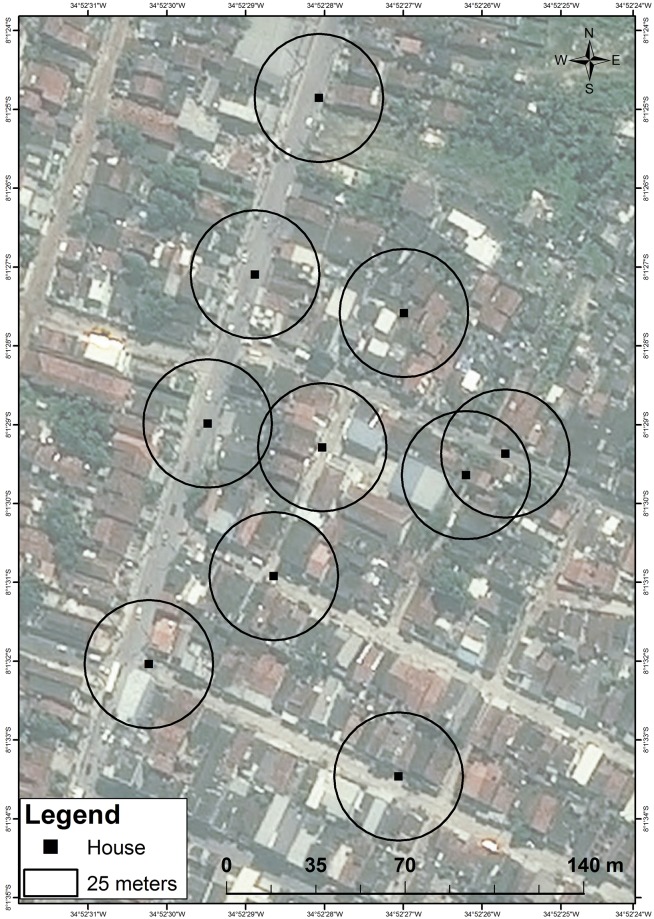
Collection method comparison (CMC) mosquito collection points via handheld aspirators and CDC light traps, Sítio Novo, Olinda, RMR, Brazil, July 22–August 21, 2015.